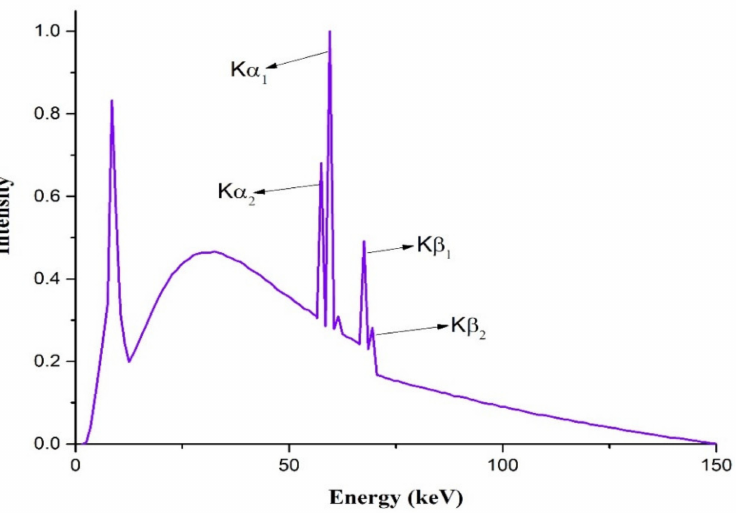
Figure 3. The applied X-ray energy spectrum in simulations obtained by the TASMIC package